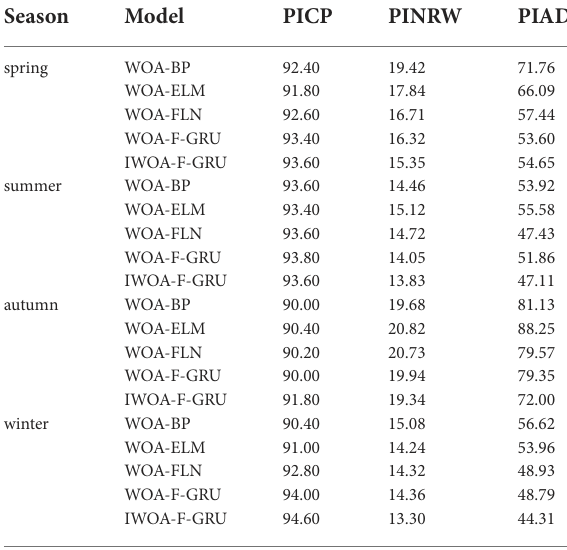
TABLE 1 Center frequencies corresponding to different K values in spring.